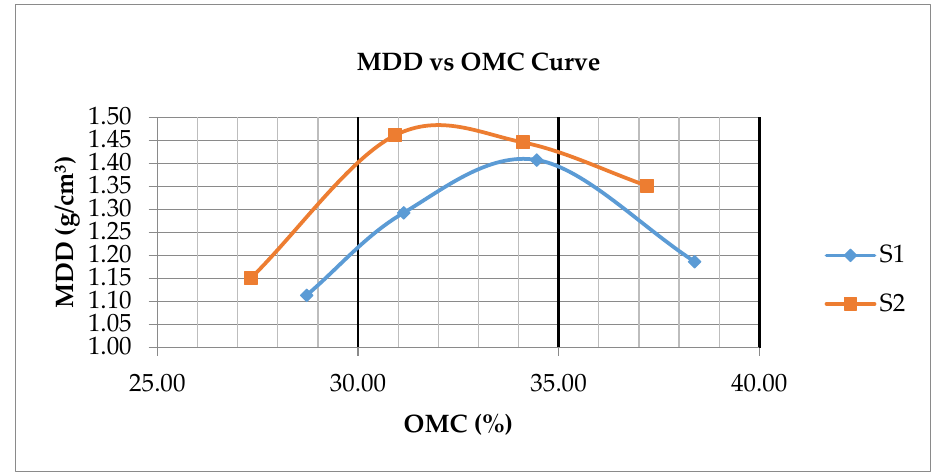
Figure 6. Maximum dry density (MDD) versus optimum moisture content (OMC) for two soil samples.